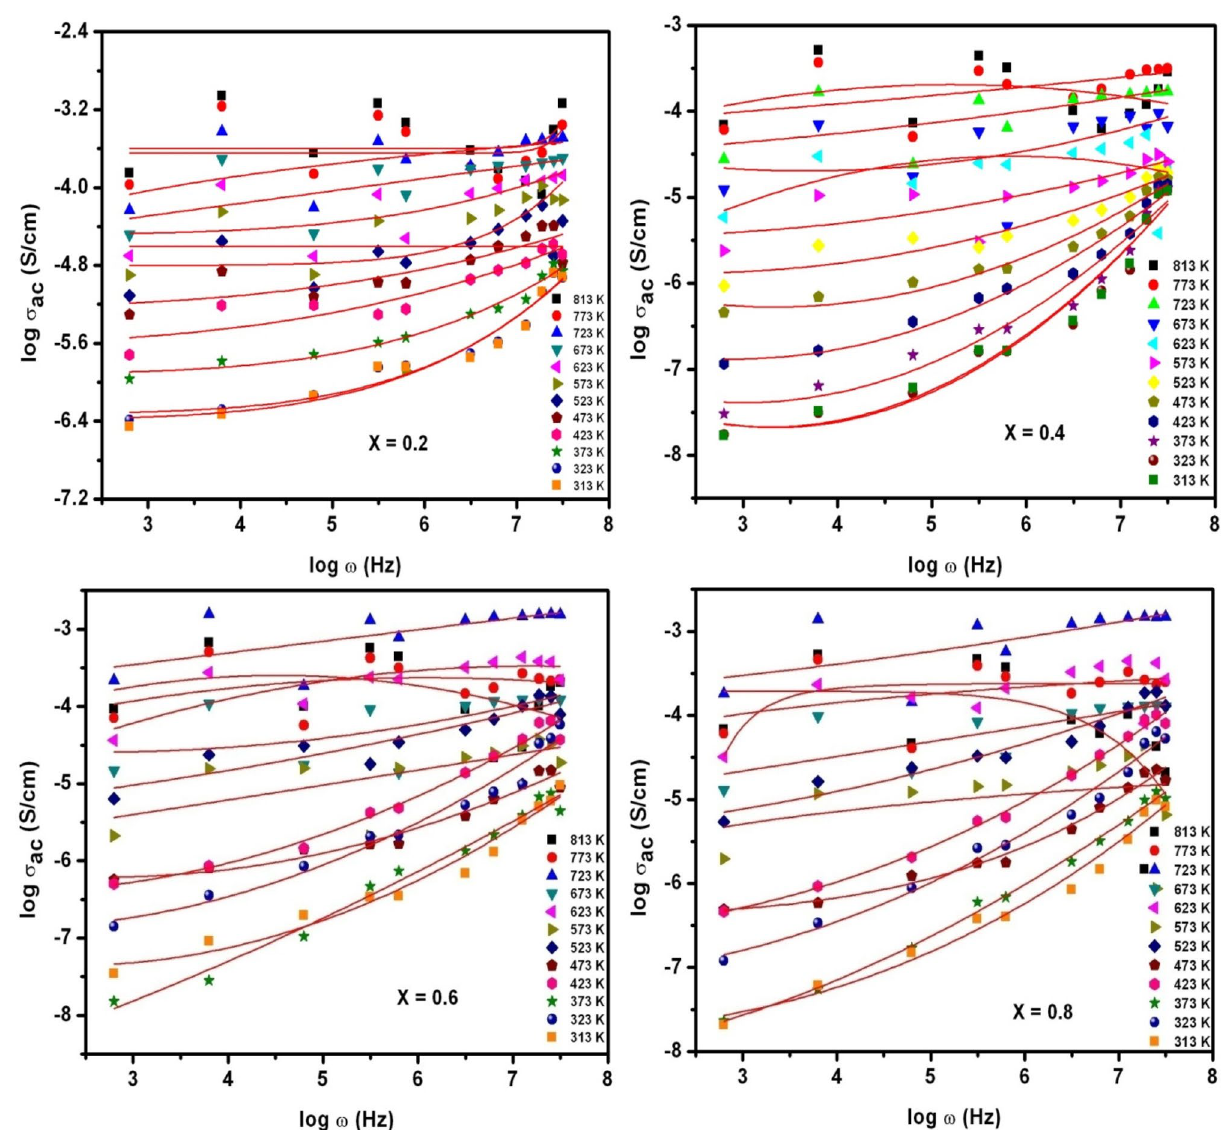
Figure 15. logσ ac versus logω plots of SLFO nanoparticles.